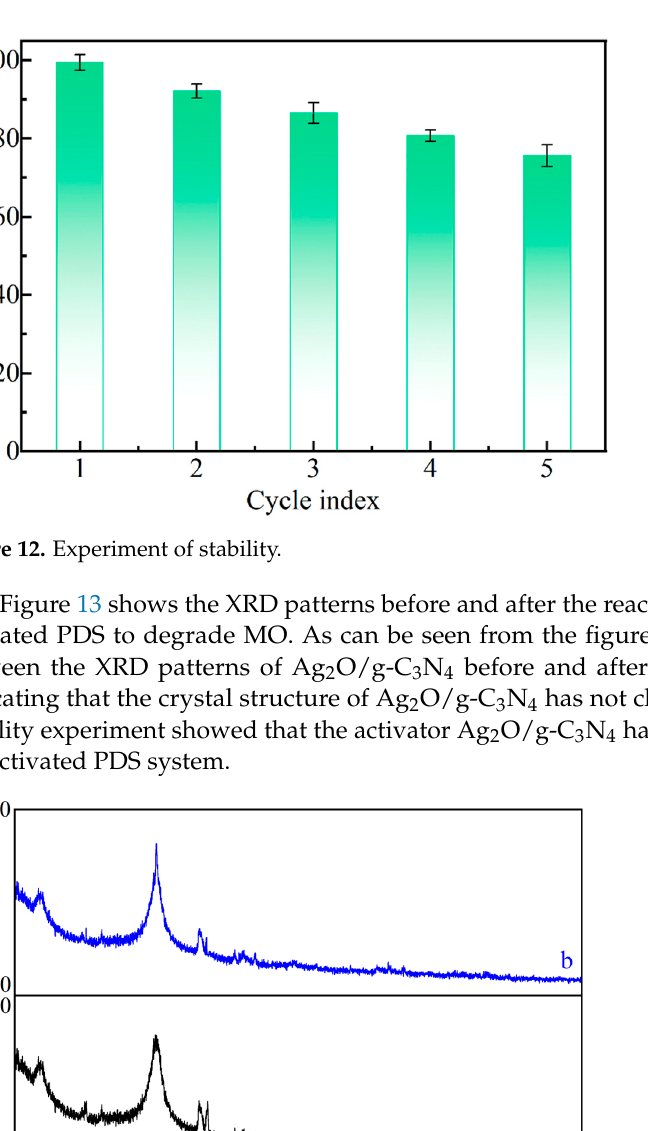
Figure 13. XRD patterns of Ag 2 O/g ‐ C 3 N 4 before ( a ) and after ( b ) the reaction.